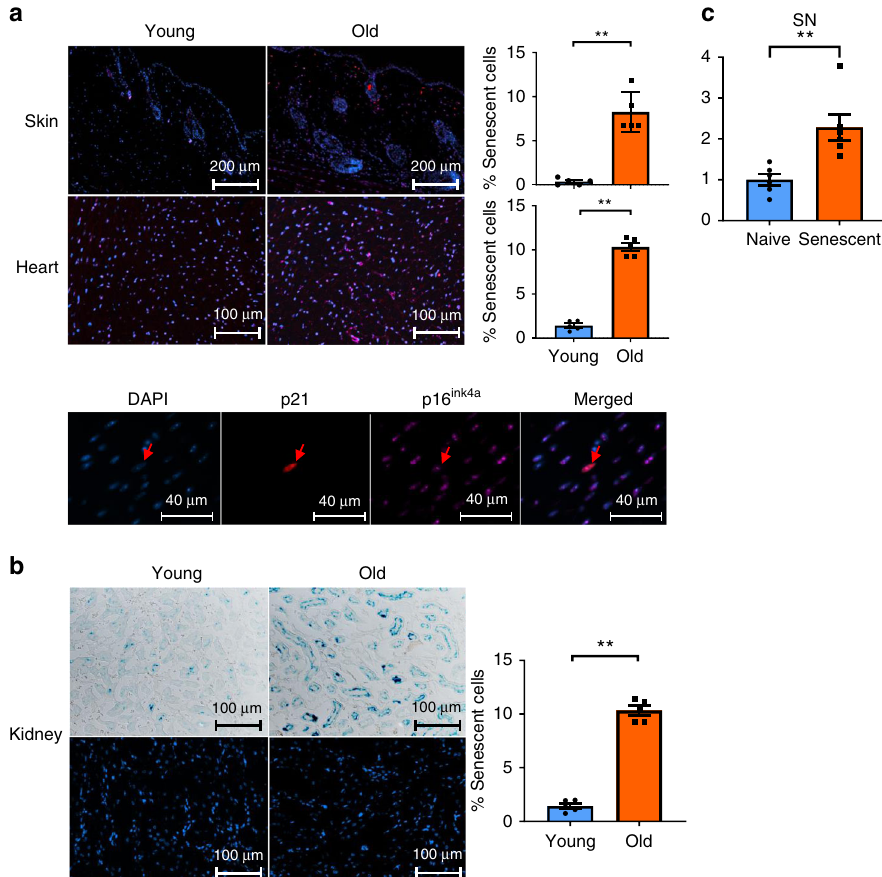
Fig. 4 Senescent cells accumulate with aging and are a source of cf-mt-DNA with aging. Skin, hearts, and kidneys were procured from old and young C57BL/6 mice and embedded in paraf fi n. a Skin and hearts were cut into slides and co-stained for p16 Ink4a , p21 Cip1 , and DAPI; b frozen slides of kidneys were made and subsequently stained for sa- β -gal. The percentage of senescent cells was de fi ned as the number of ( a ) p16/p21 double-positive cells or ( b ) sa- β -gal-positive cells of DAPI-stained cells using a confocal microscope ( p = 0.0079), ( n = 5 biologically independent animals). c Mouse adipocytes were isolated from C57BL/6 mice and senescence induced using 30 serial passages or 10 Gy irradiation. Cf-mt-DNA levels were measured in supernatants by real-time PCR comparing senescent and naive cell cultures ( p = 0.0022); ( n = 6 biologcially independent samples); column plots display mean ± SD, results are representative of at least three independent experiments. Statistical signi fi cance was determined by using two-tailed Mann – Whitney test. Asterisks indicate p values * p ≤ 0.05, ** p ≤ 0.01, and *** p ≤ 0.001, **** p ≤ 0.0001, only signi fi cant values are shown. Source data are provided as a Source Data fi